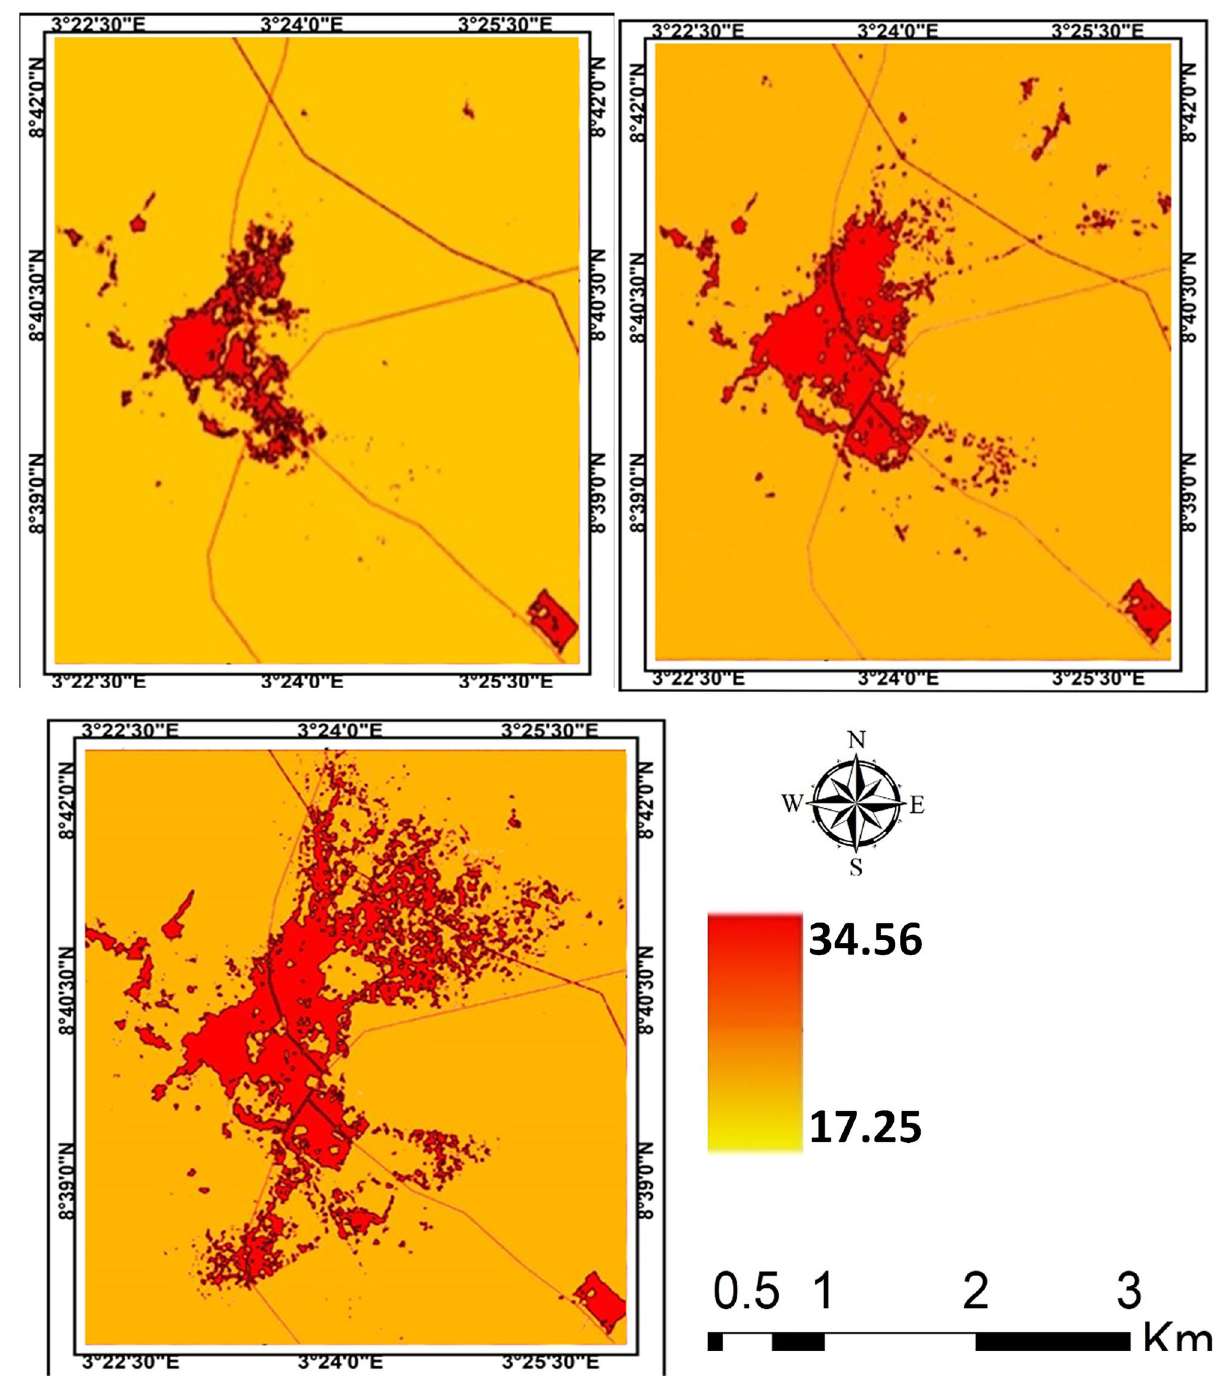
Figure 6. Land surface temperature intensity over Saki from 1984 to 2019. The figure was generated using Quantum GIS (QGIS 3.4) software (https:// qgis. org/ en/ to 837.95 km 2 in 2019. However, the vegetation decreases significantly from 1357 km 2 in 1984 to 1067 km 2 in 2004 and many reductions in 2019 to about 701 km 2 (Table 7). What is obvious from these results is that as both built-up within the city and the cultivation land around the city expanding, vegetation decreases (Fig. 7a), lead- ing to much of the LST intensification in the city (Fig. 3). A similar scenario is obvious in Ibadan in 1984 where for instance, the built-up and cultivation increase from 101 km 2 and 242 km 2 to 343 km 2 and 269 km 2 in 2019, respectively. These expansions decrease in vegetation land from 702 km 2 in 1986 to 434 km 2 in 2019 (Table 7). In Lagos in 1984, the built-up was about 296 km 2 but increased each year to 1053 km 2 in 2019 Cultivation, however, decreased from 193 km 2 in 1984 to nearly 165 km 2 in 2019. The reason for the reduction in cultivation land in Lagos is obvious, since the city is a major industrial location in the country, only a few lands are used for